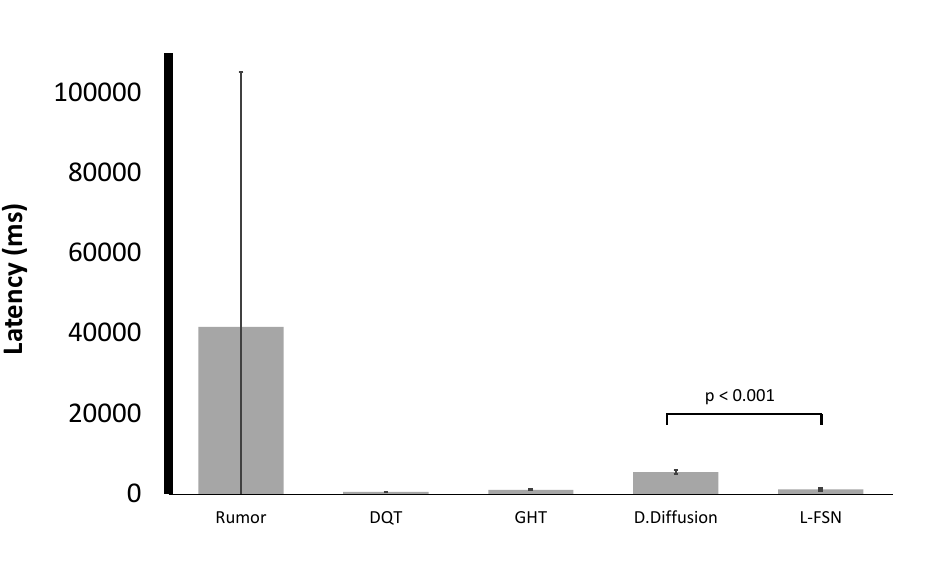
Figure 6. The data delivery